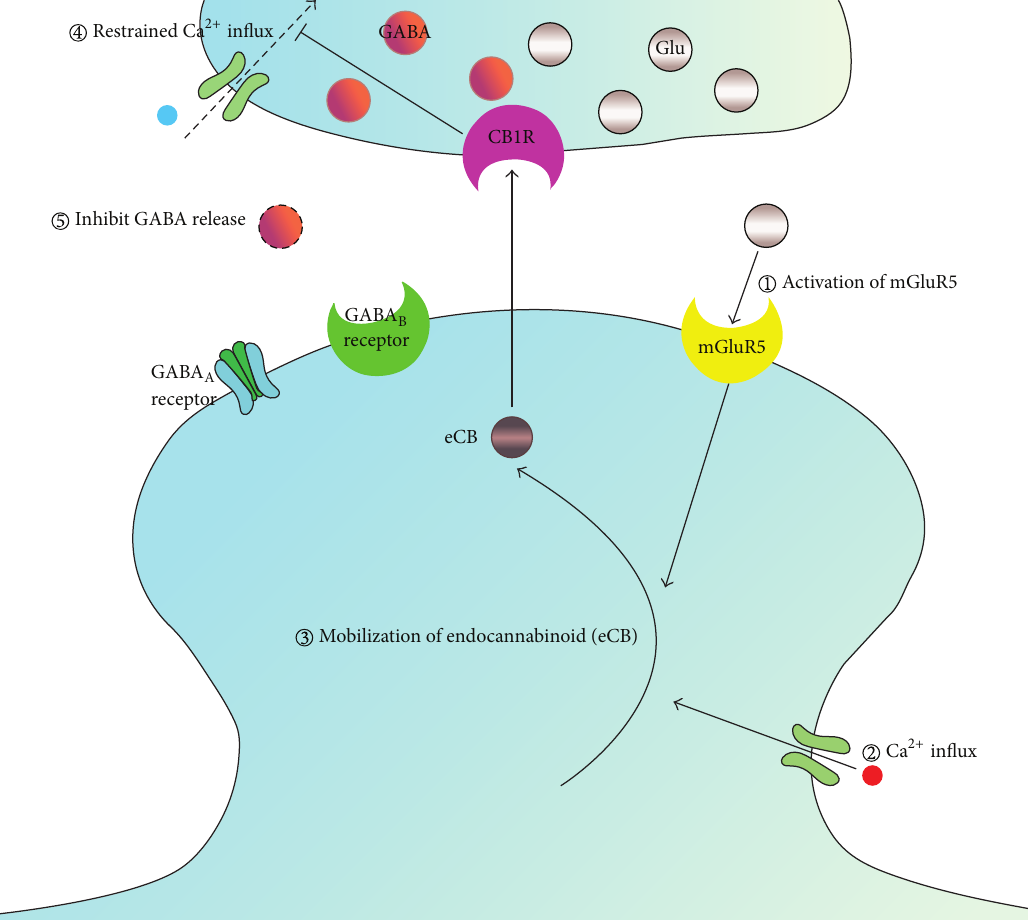
Figure 2: Potential patterns linking mGluRs theory and GABA theory which influence synaptic plasticity involving proteins regulated by FMRP.ActivationofGp1mGluRsenablesthemobilizationofendocannabinoids(eCB)inthepostsynapticneuronandretrogradelymodulates GABA release through a mechanism known as depolarization-induced suppression of inhibition (DSI). In the whole process, Ca 2+ influx into postsynaptic neuron participates in the mobilization of endocannabinoids, whereas at presynaptic neuron, Ca 2+ influx into the cytoplasm restrained by endocannabinoids participates in the inhibition of GABA